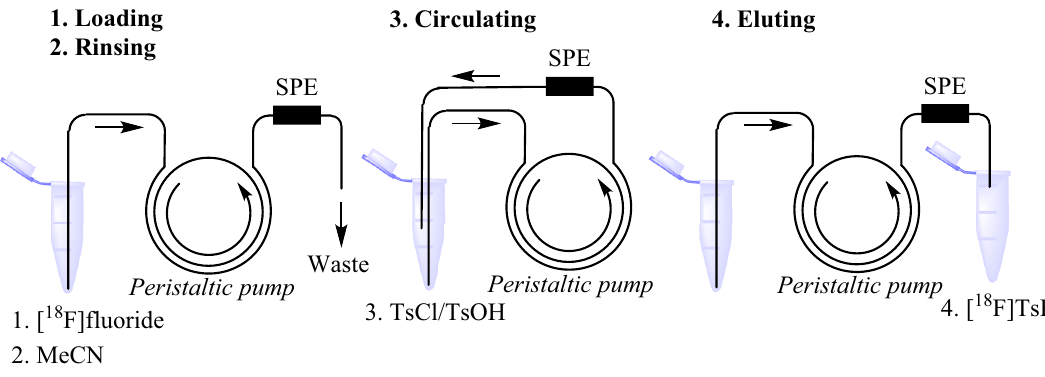
Figure 2. Manual generation of [ 18 F]TsF using a peristaltic pump as a proof of concept of continuous flow solid-phase radiosynthesis of [ 18 F]TsF. The steps include ( 1 ) loading [ 18 F]fluoride onto the SPE cartridge and ( 2 ) drying the SPE cartridge using acetonitrile, ( 3 ) circulating a solution of TsCl/TsOH·H 2 O, and ( 4 ) eluting [ 18 F] TsF from the SPE cartridge. For greater details, see “Methods” section.